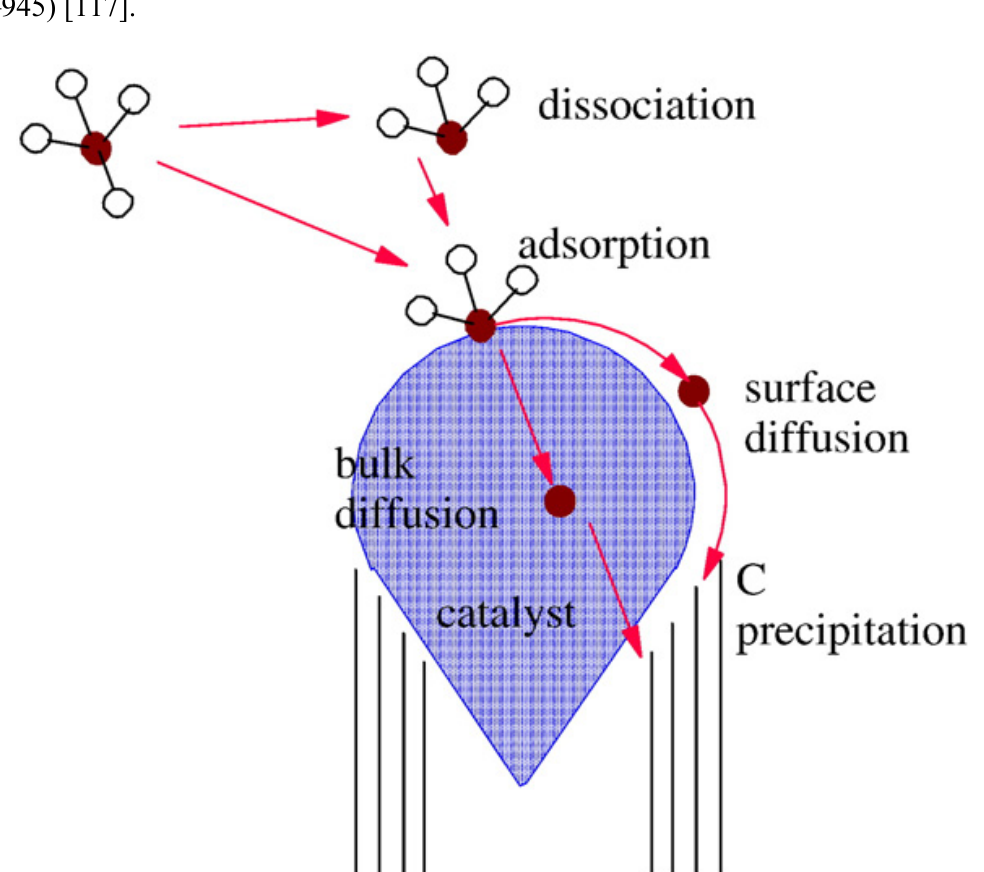
Figure 5. Schematic of reactions and processes on a catalytic nano-particle during nanotube growth (tip growth illustrated). (Wirth, C.T.; Hofmann, S.; Robertson J. State of the catalyst during carbon nanotube growth. Diamond Relat. Mater. 2009 , 18